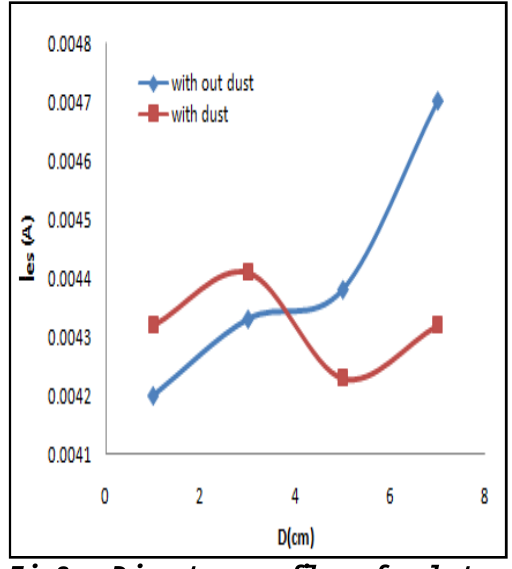
Fig.8: Diameter profile of electron saturation current at different distances of the probe.